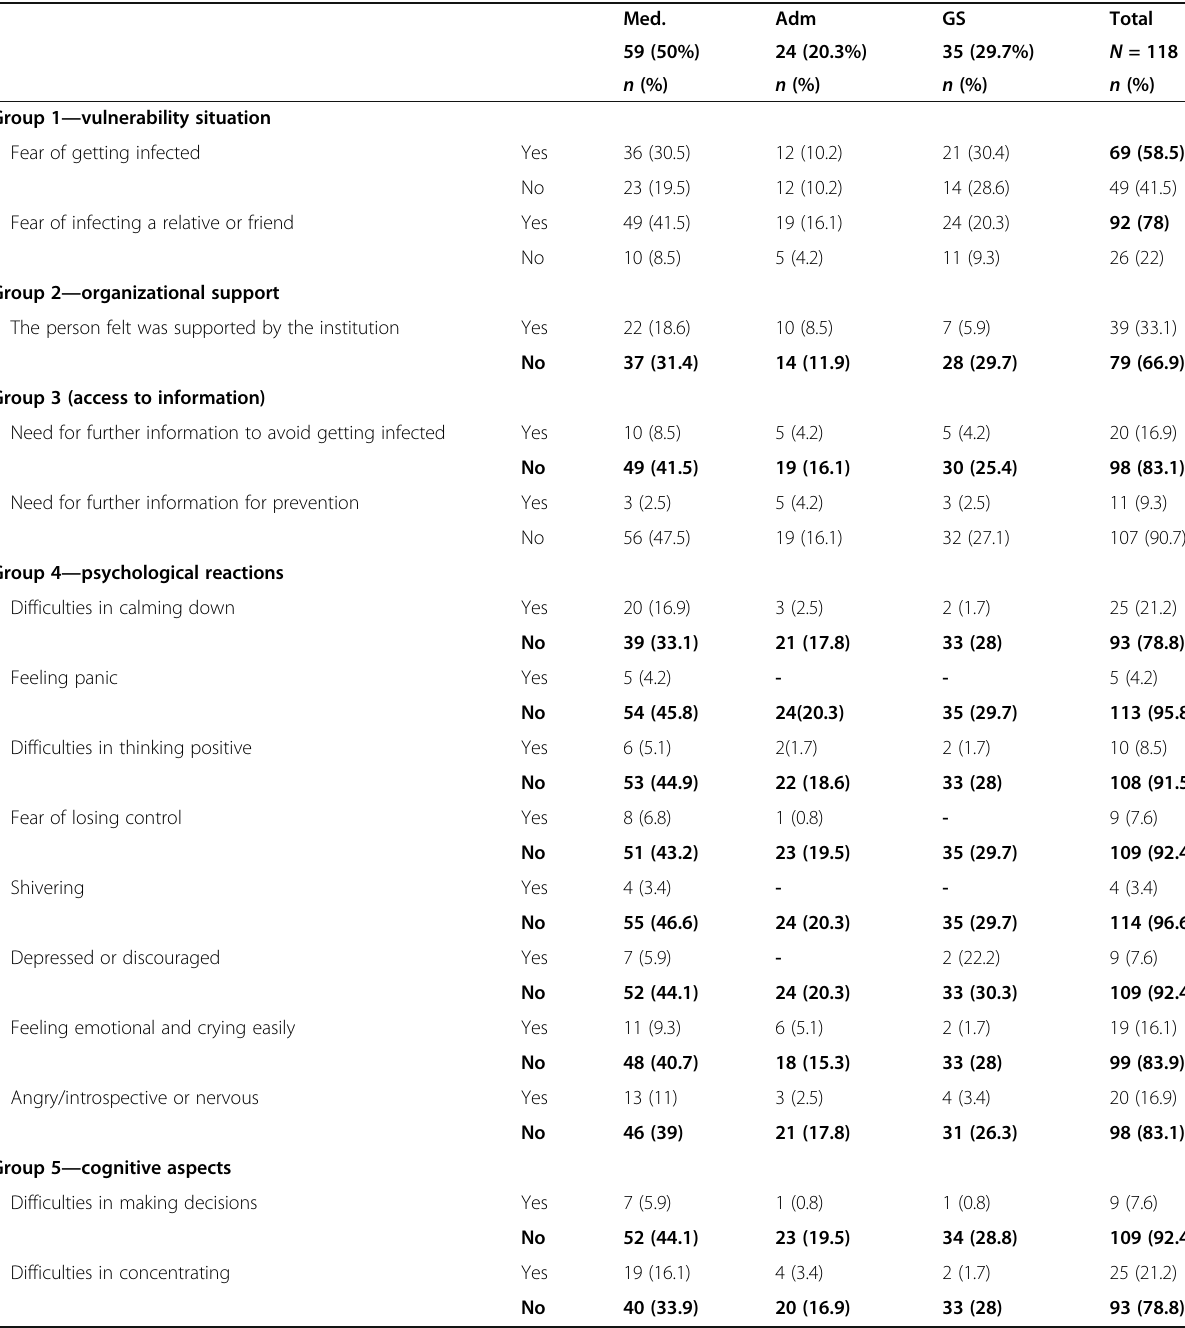
Table 3 Group analysis of program demands —